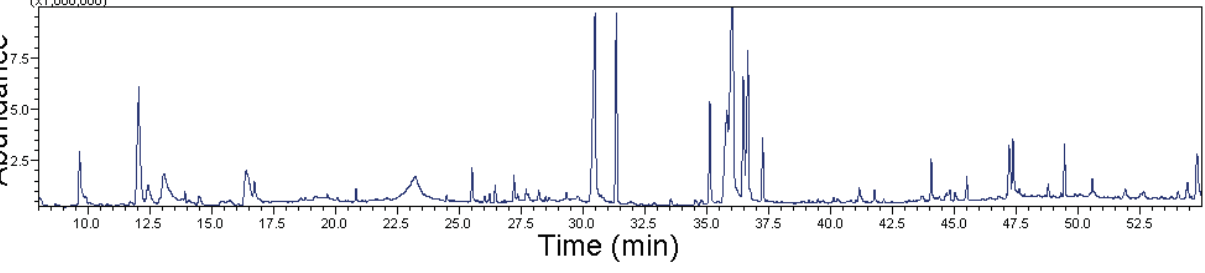
Table 1. Chemical composition of ethanolic extract of E. hirta tentatively identified by GC-MS. S.